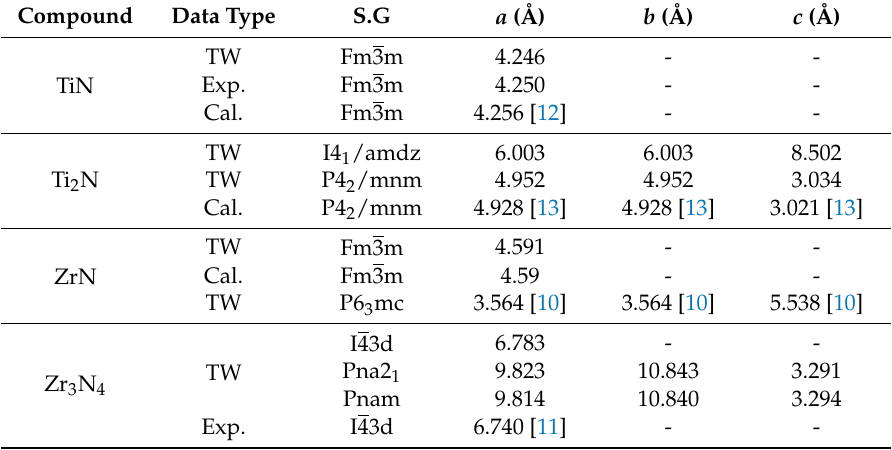
Table 2. Data calculated in this work (some experimental data and some the results of others) of TiN, Ti 2 N, ZrN and Zr 3 N 4 under zero pressure. (TW = this work, Exp = exsperiment, Cal. = other calculated, Space group = S.G).